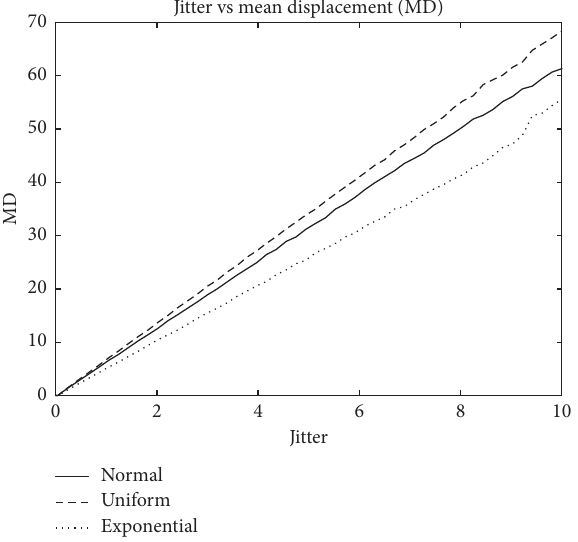
Figure 4: MD for diverse jitters . Figure 5: E